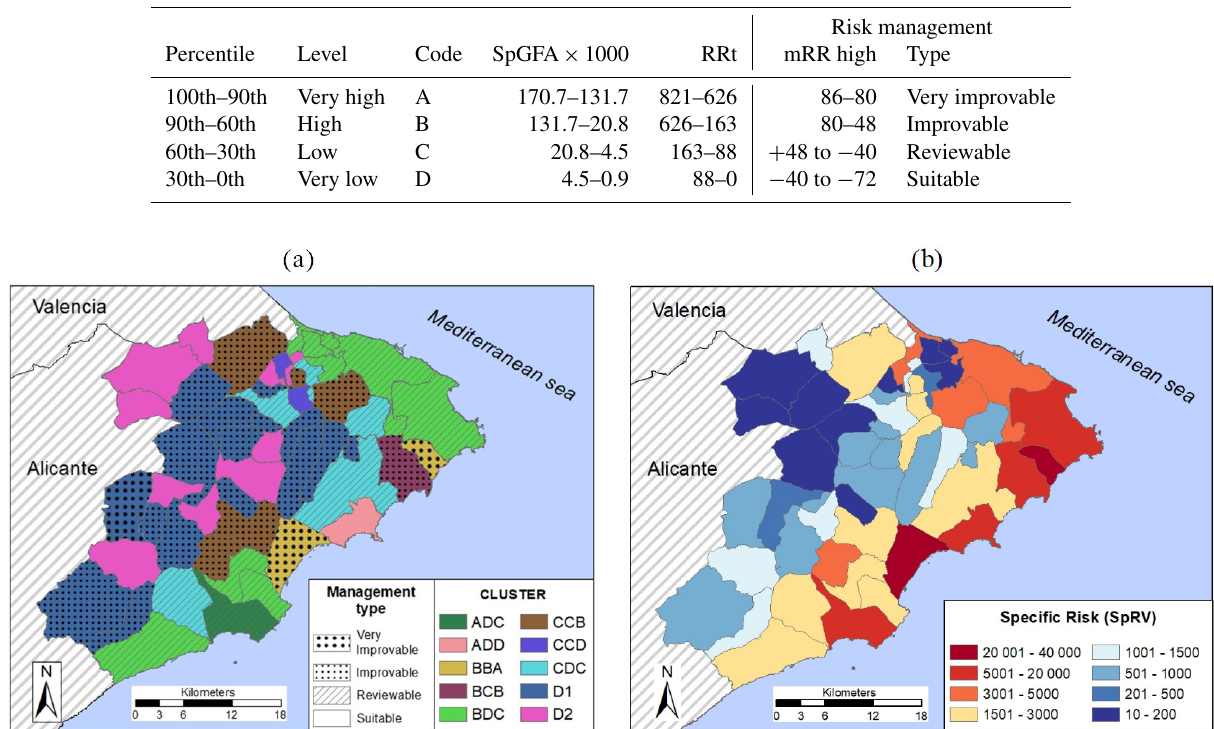
Figure 8. Map of La Marina: (a) with cluster groups ∗ ; (b) with the SpRV value. ∗ D1 clusters: DAA, DBB and DDB; D2 clusters: DAD, DBD and